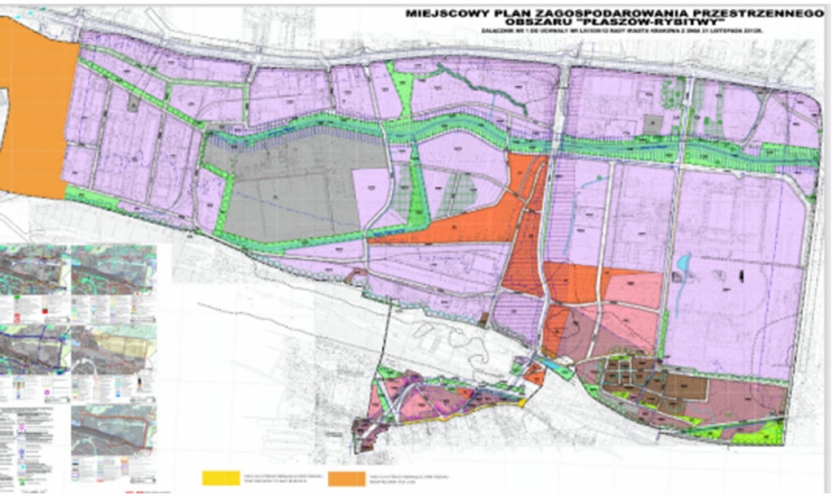
Figure 5. Changes in the approach to industrial and post-industrial areas in the B-Cracow Ry-bitwy area. MPZP—Status for 2013 [22].